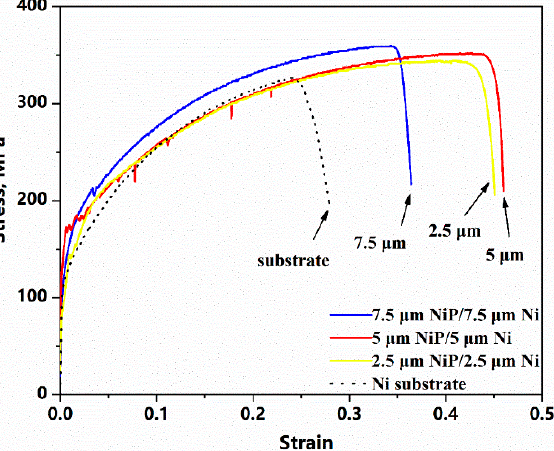
Figure 3. Engineering stress–strain curves of the composite coating specimens with different layer thicknesses.